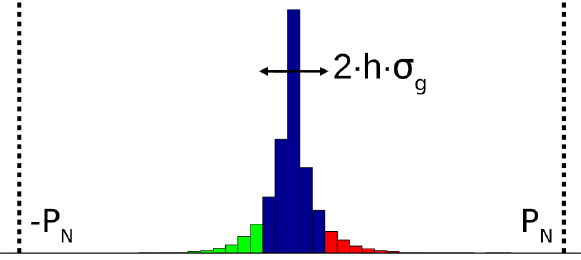
Figure 1. Histogram of local gradient time series g t (case for h = 1). Fig. 1. Histogram of local gradient time series g t (case for h = 1 ). P N stands for the rated power of the wind farm. Local gradients P N stands for the rated power of the wind farm. Local gradients triggering Ramp-up and Ramp-down regimes are in red and green triggering Ramp-up and Ramp-down regimes are in red and green colour colour respectively